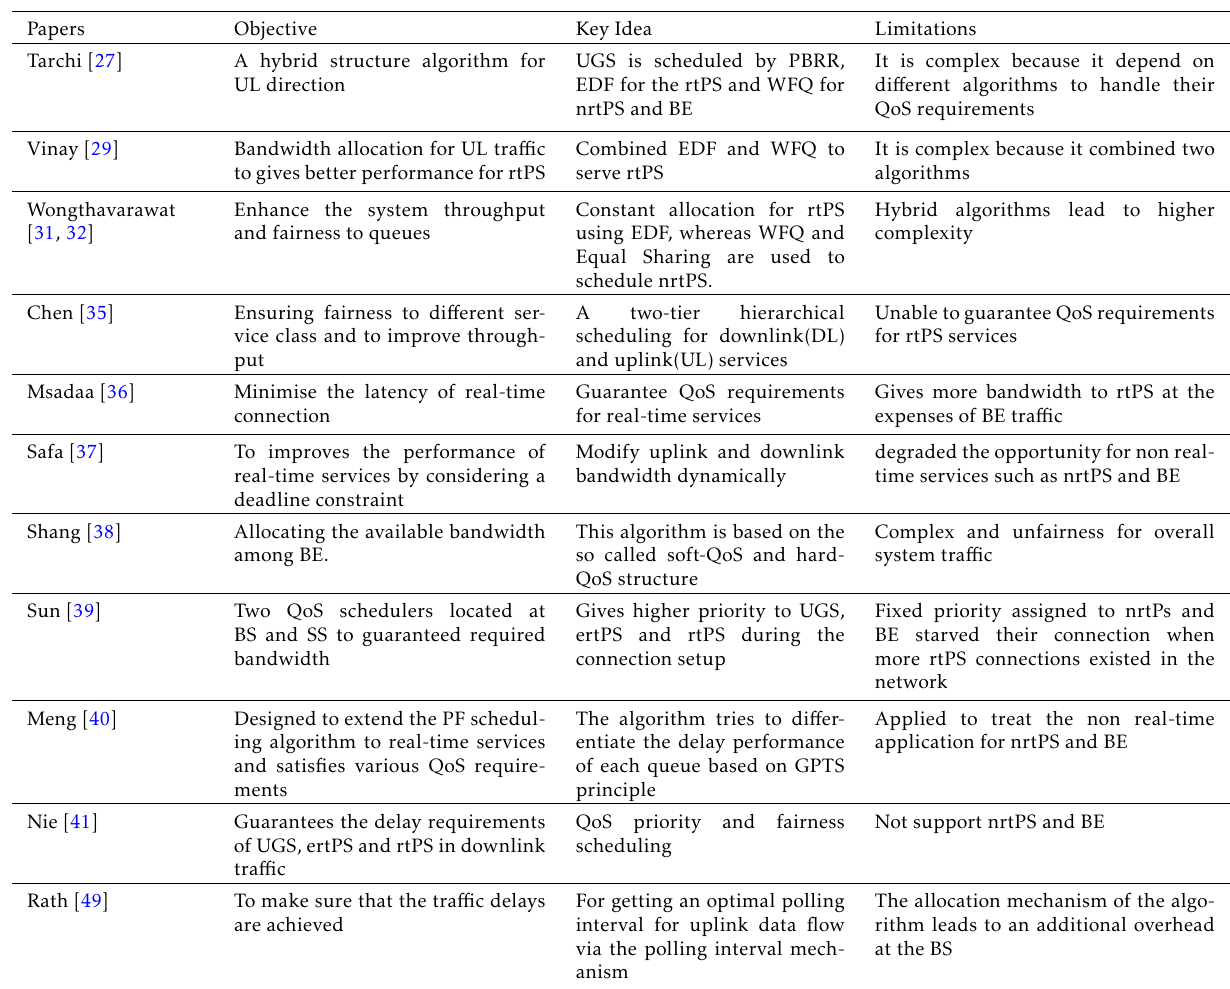
Table 3. Summary of various LTE Scheduling